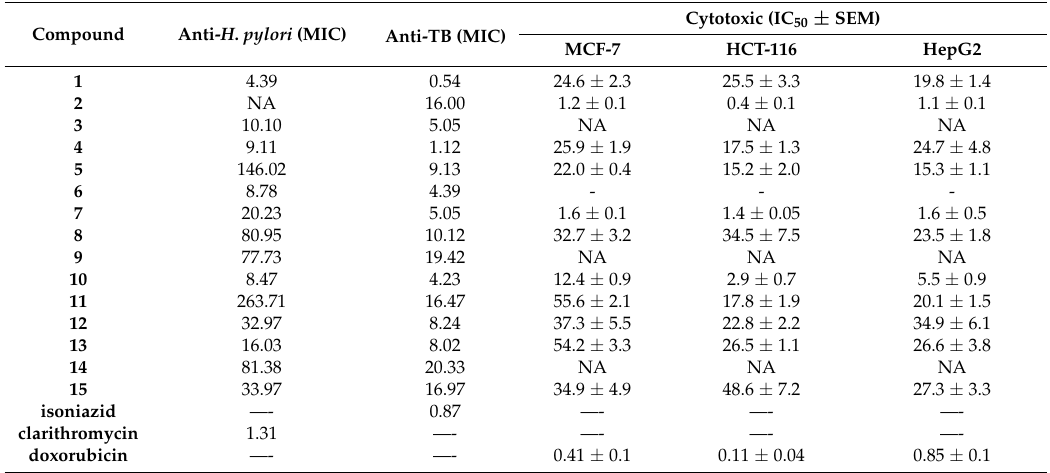
Table 2. Anti- H. pylori , antitubercular and cytotoxic activities of Compounds 1 – 15 in µ M.